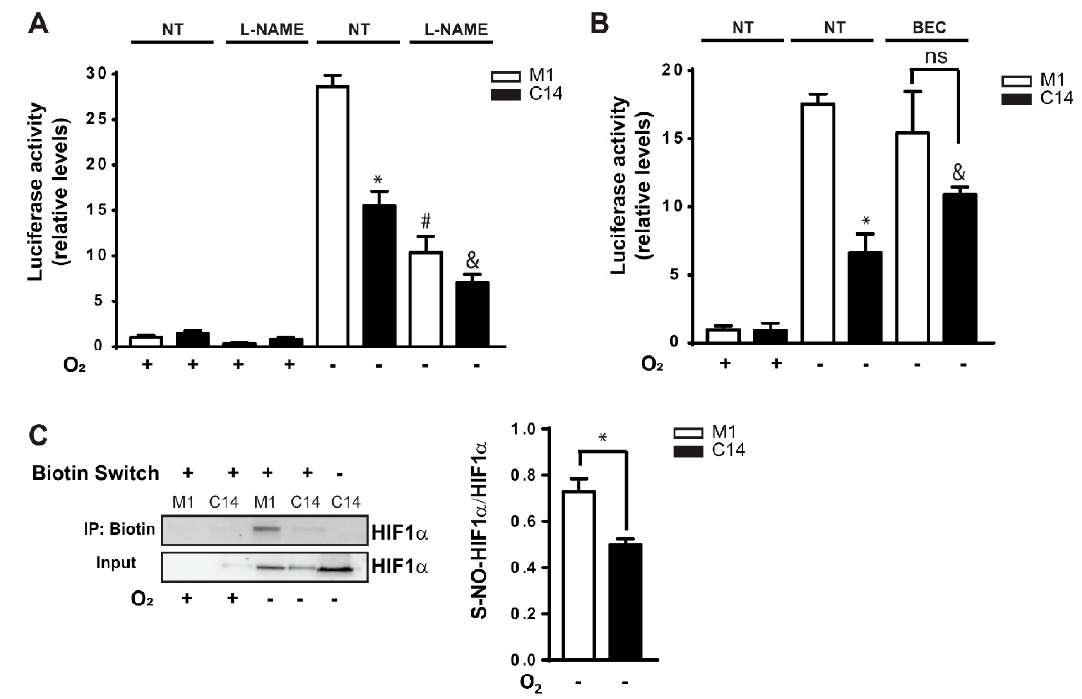
Figure 4. CAV1-mediated HIF1 α inhibition involves alterations in nitric oxide synthase activity and HIF1 α S-nitrosylation. ( A ) Effect of nitric oxide synthase (NOS) inhibition. HT29(US) cells (M1, white; C14, black bars) were incubated with the general NOS inhibitor L-NAME (10 mM) in normoxia